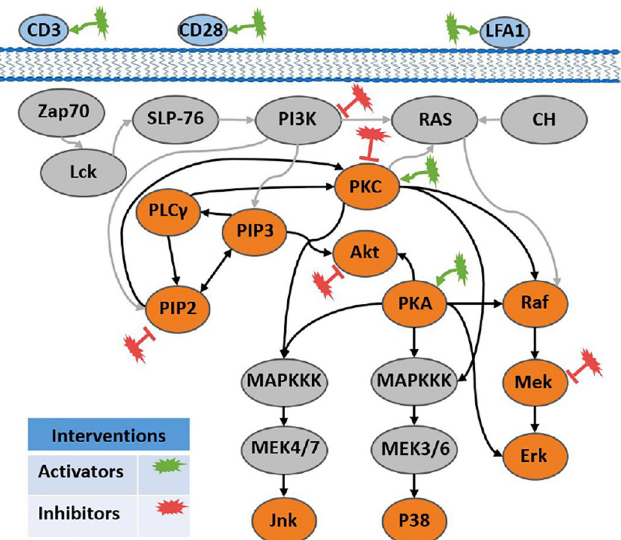
Fig 2. Biological network for the Sachs et al. study, showing interactions (arcs) and interventions (starred ellipses). The pathways represented by bold black lines are the Ground Truth known causal interactions, established through literature